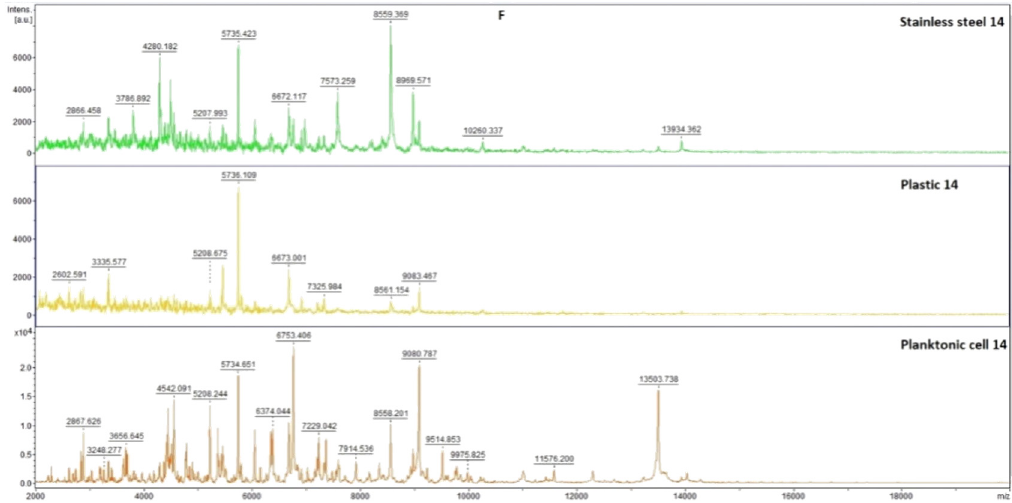
Figure 7. MALDI-TOF mass spectra of P. fluorescens during the development of biofilm: ( A ) 3rd day, ( B ) 5th day, ( C ) 7th day, ( D ) 9th day, ( E ) 12th day, and ( F ) 14th day.